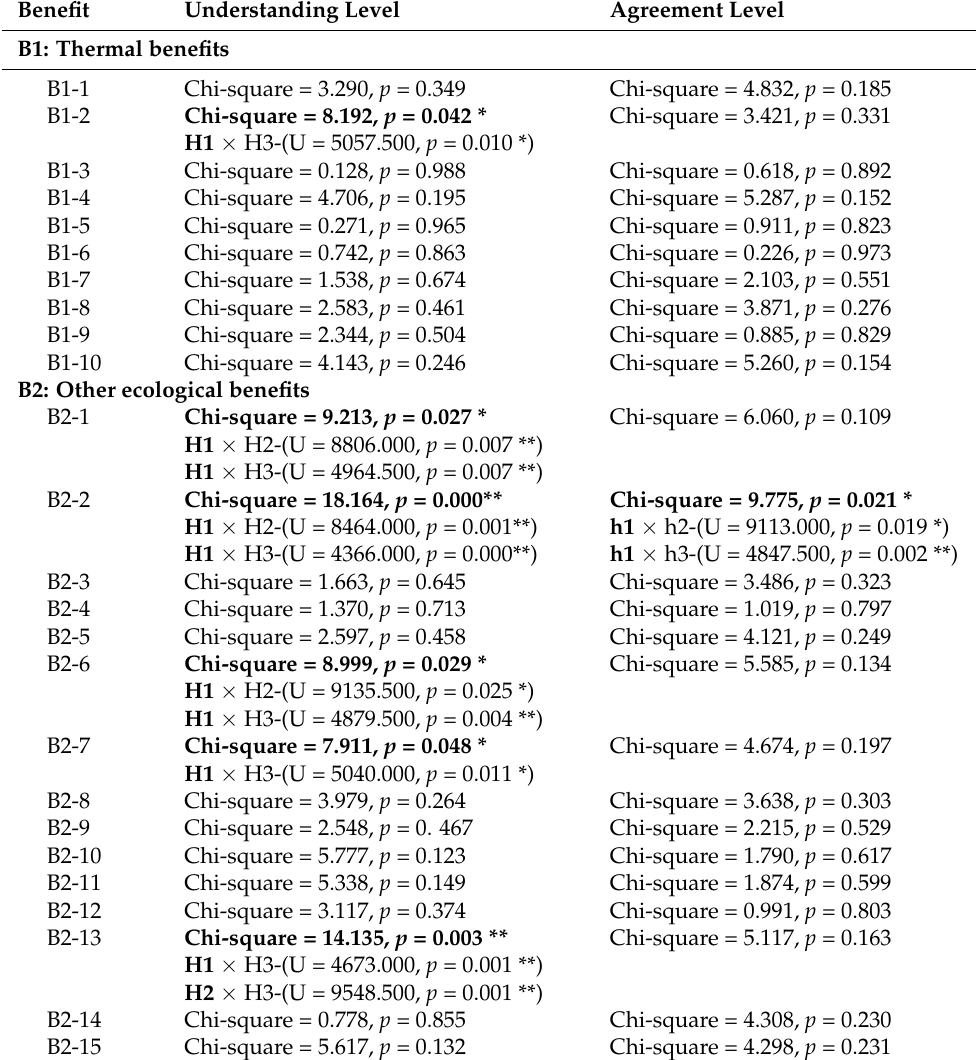
Table 7. Impact of self-rated health status on respondents’ perceptions of UGS ecological benefits a . Benefit Understanding Level Agreement